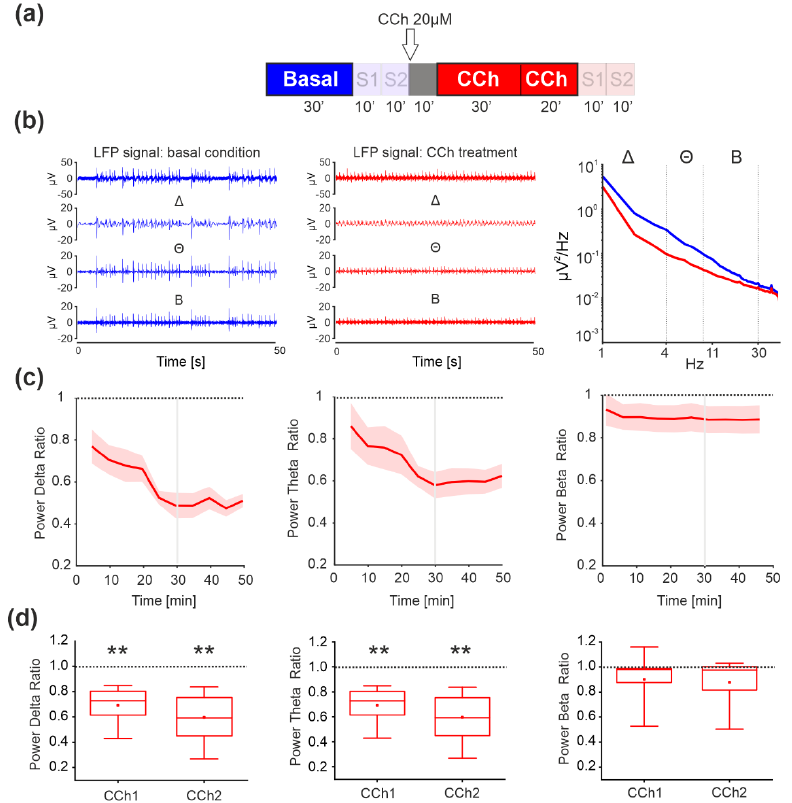
Figure 2. Analysis of local field potentials (LFP) during the basal and CCh phases, to evaluate differences in spontaneous activity. ( a ) Experimental protocol adopted for the experiments. The spon- taneous phases (i.e., without electrical stimulation) analyzed here are highlighted. Cortical cultures were recorded for 3 0′ under basal conditions followed by 1 h of recording after the addition of 20 μM CCh. ( b ) Signal filtered to specific frequency bands involved in sleep for one channel of a rep- resentative experiment: local field potential (LFP) signals obtained after band-passing the raw data in the range 1 – 300 Hz. Different components of the LFP: delta frequency signal (Δ, 1 – 4 Hz), theta frequency signal (Θ, 5 – 9 Hz), and beta frequency signal (Β, 1 0 – 30 Hz). CCh treatment induced sup- pression of all low-frequency waves compared to the control condition in one representative exper- iment (right panel). ( c ) Time course of the power spectral density ratio (CCh over basal) computed in delta, theta, and beta power. ( d ) Box plot comparison of the PSD of each band showing a marked decrease in the delta and theta bands ( n = 9 MEAs recorded, p = 10 −5 ). We did not find any difference in the PSD in the beta bands. The bold lines and shaded regions in ( c ) correspond to the mean ± SEM. In each box plot, the small red square indicates the mean, the central red line illustrates the median, and the box limits indicate the 25th and 75th percentiles. Whiskers represent the 5th and the 95th percentiles. Statistical analysis was conducted using the Mann – Whitney comparison test; * p < 0.05; ** p < 0.01.